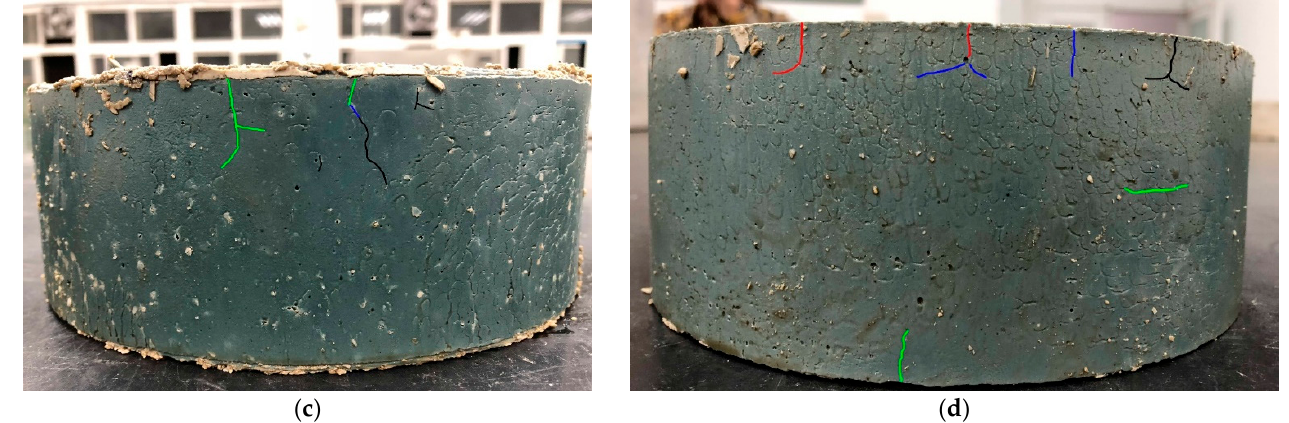
Figure 13. Effects of different polymer materials on the cracking behavior of GGBFS geopolymers. ( a ) Crack development in the control group. ( b ) Crack development with 0.7% PAM added. ( c ) Crack development with 0.7% SP added. ( d ) Crack development with 0.7% ST added. (The red, blue, green, and black lines represent the crack propagation generated after 6 h, 1 day, 2 days, and 3 days).